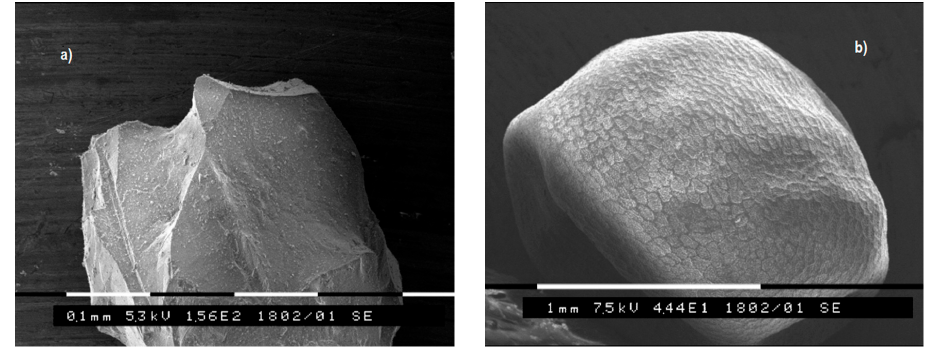
Figure 2. Relatively smooth surface topography of olivine, SSA ≈ 1 m 2 ∙ g − 1 ( a ) and bio-sample of rapeseed oil having bio-topography ( b )—where the surface area was not measured. Scale bars: (a) 0.1 mm, (b) 1 mm.